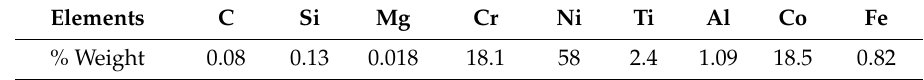
Table 1. Chemical composition of